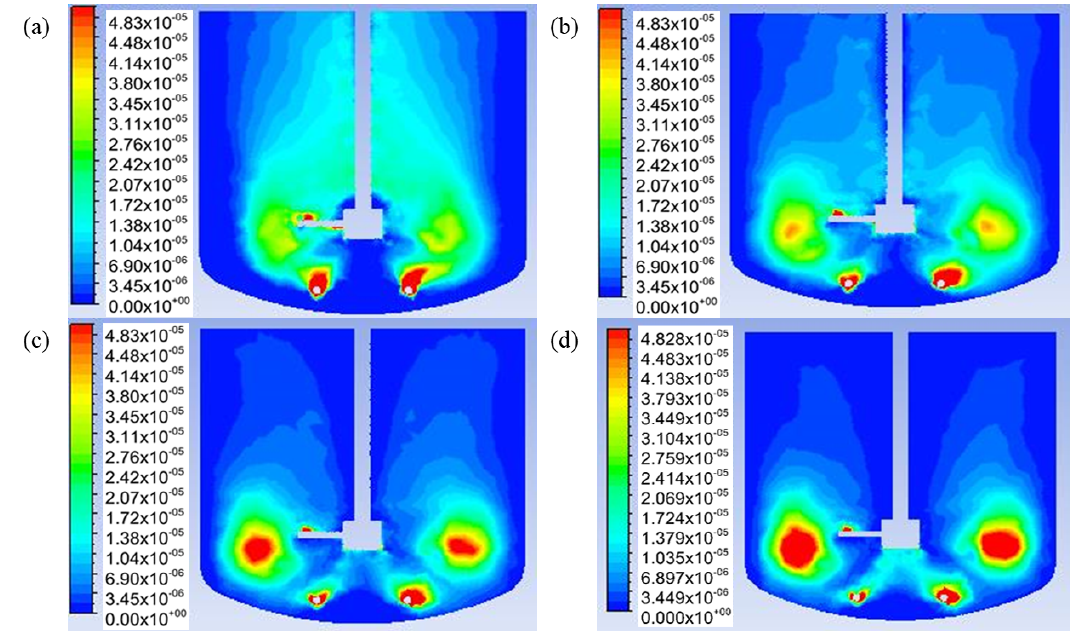
Figure 9. Gas holdup contour. ( a ) N = 100 rpm; ( b ) N = 200 rpm; ( c ) N = 300 rpm; ( d ) N = 400 rpm.